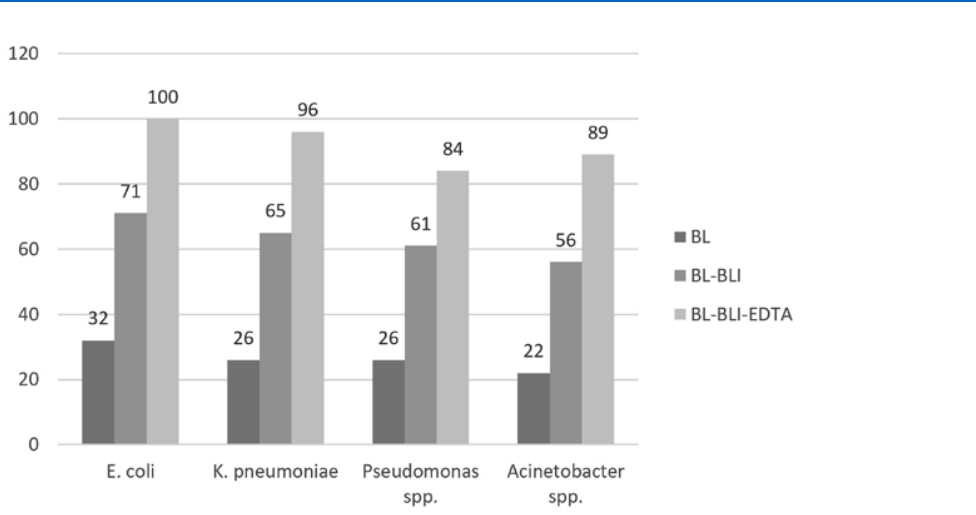
Fig. 3. Comparative susceptibility of CSE with beta lactam and beta lactam-beta lactamase inhibitor Note: BL (beta lactam, Ceftriaxone), BL-BLI (beta lactam-beta lactamase inhibitor, Piperacillin-tazobactam), CSE: Ceftriaxone+Sulbactam+EDTA (BL-BLI-EDTA combination), EDTA: ethylene-diamine-tetraacetic